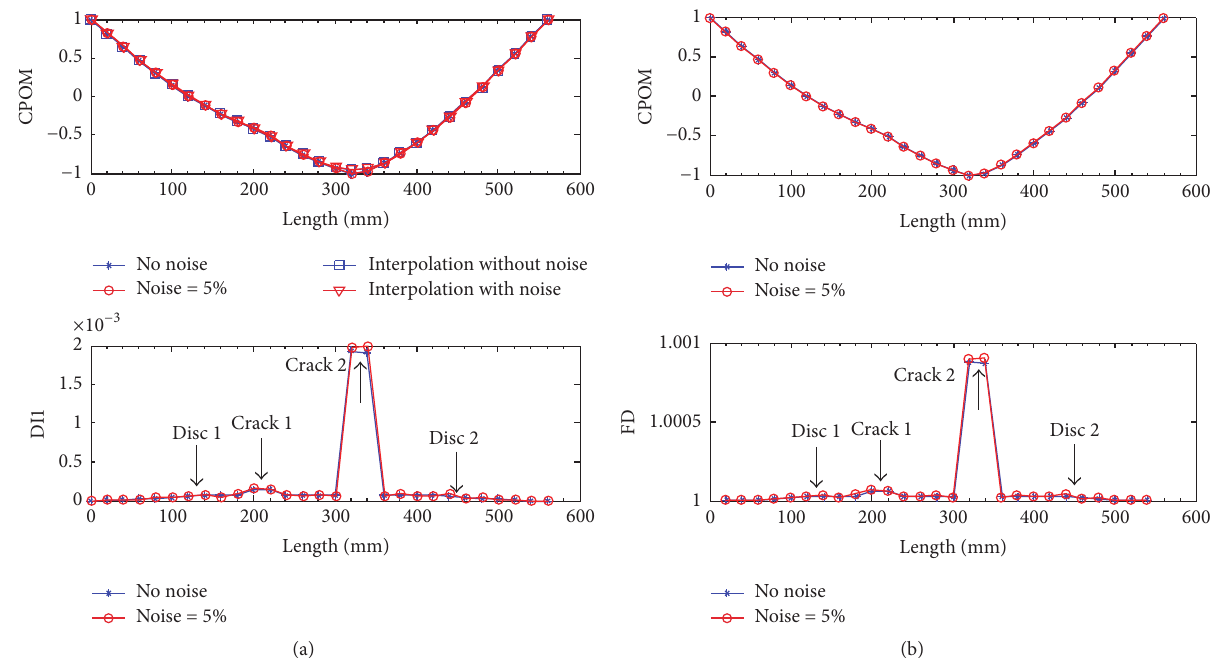
Figure 15: Localization results of double-cracked rotor in case 8. (a) Localization using GSM by linear gapped interpolation. (b) Localization using FD.